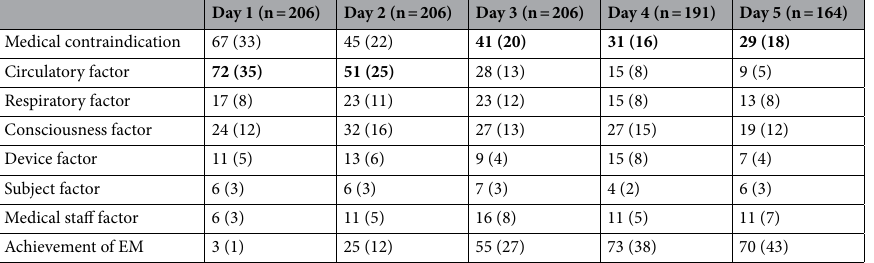
Table 3. Primary barriers preventing the achievement of early mobilization. Number of patients (%). EM early mobilization, ICU intensive care unit. Significant values are in bold.